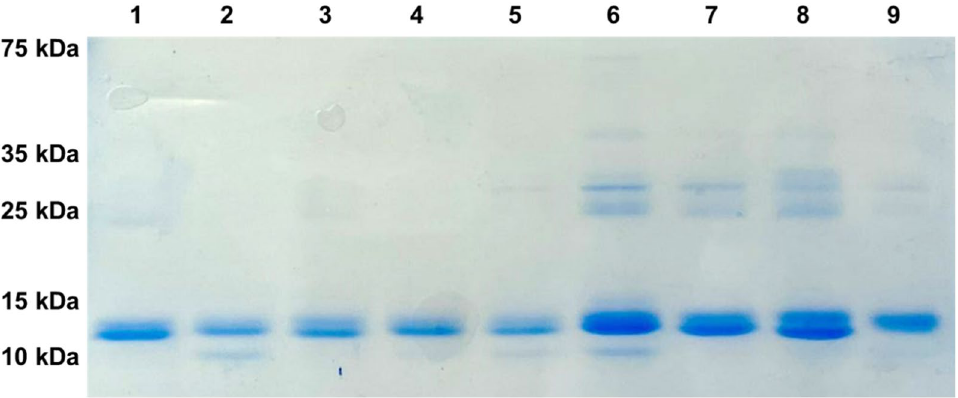
Figure 2. SDS-PAGE analysis of purified N-TIMP2 variants. All proteins were in the expected size of ~ 15 kDa. Lane 1, N-TIMP2; Lane 2, N-TIMP2-S2DOPA; Lane 3, N-TIMP2-S69DOPA; Lane 4, N-TIMP2-A70DOPA; Lane 5, N-TIMP2-L100DOPA; Lane 6, N-TIMP2-S2HqAlA; Lane 7, N-TIMP2-Y36HqAlA; Lane 8, N-TIMP2- S69HqAlA; Lane 9, N-TIMP2-A70HqAlA. Samples were run on 15% polyacrylamide gel under reducing